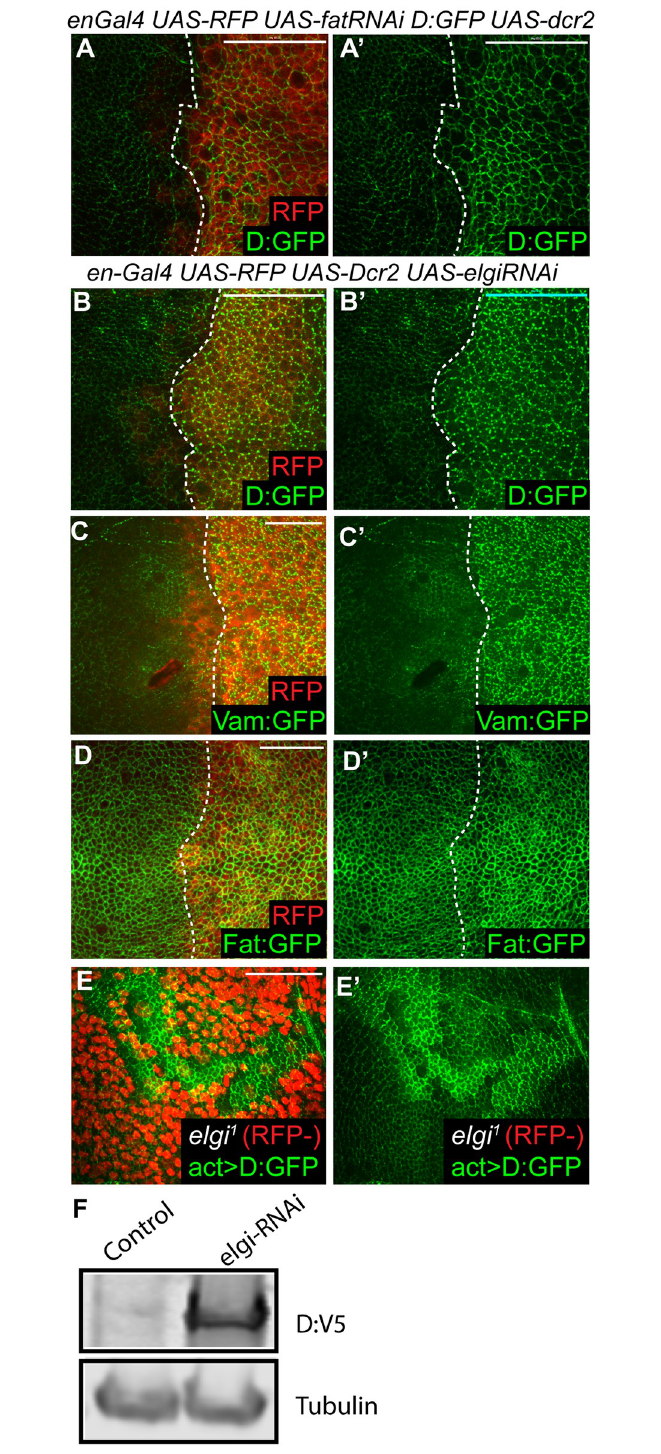
Fig 2. elgi regulates the levels of Dachs, Vam and Fat. (A-D) Horizontal apical sections of wing imaginal discs expressing en-Gal4 UAS-Dcr2 UAS-RFP (red) with either UAS-fat-RNAi (A) or UAS-elgi-RNAi (B-D) and Dachs : GFP (D : GFP) (A, B), Vam : GFP (C) or Fat : GFP (D) showing increased levels of membrane localized Dachs:GFP, Vam:GFP and Fat:GFP in the posterior compartment. A and B were imaged using the same acquisition settings. (E) Horizontal apical sections of wing imaginal discs expressing Dachs:GFP under the control of the actin5C promoter ( act > D :